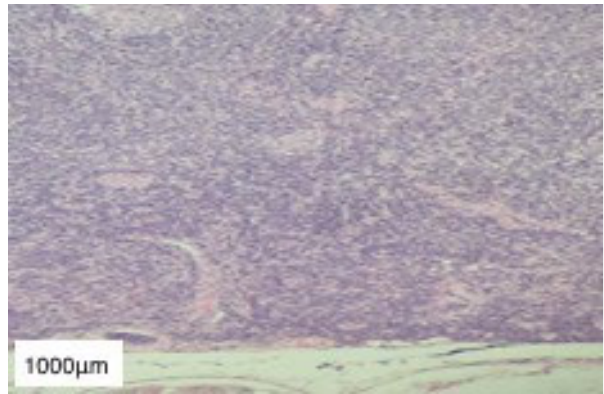
Figure 6. HE staining (20×) of sentinel lymph node biopsy which describes no metastatic involvement of the axillary nodes. Scale bar: 1000 μm.